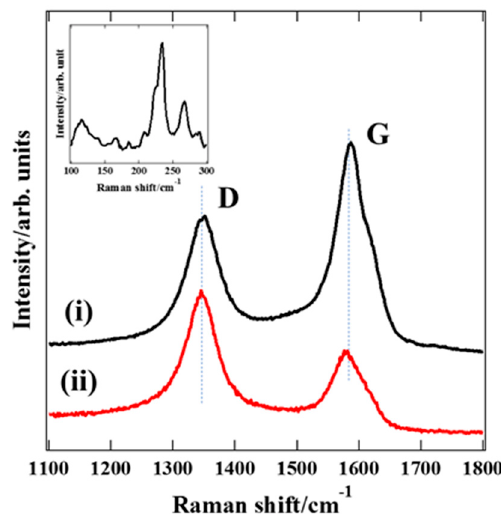
Figure 9. Raman spectra of the CNTs grown with ( i ) Fe nanoparticles and ( ii ) Fe 0.5 Mn 0.5 nanoparticles. Inset shows the RBM of ( i ) in the range of 100–300 cm − 1 .